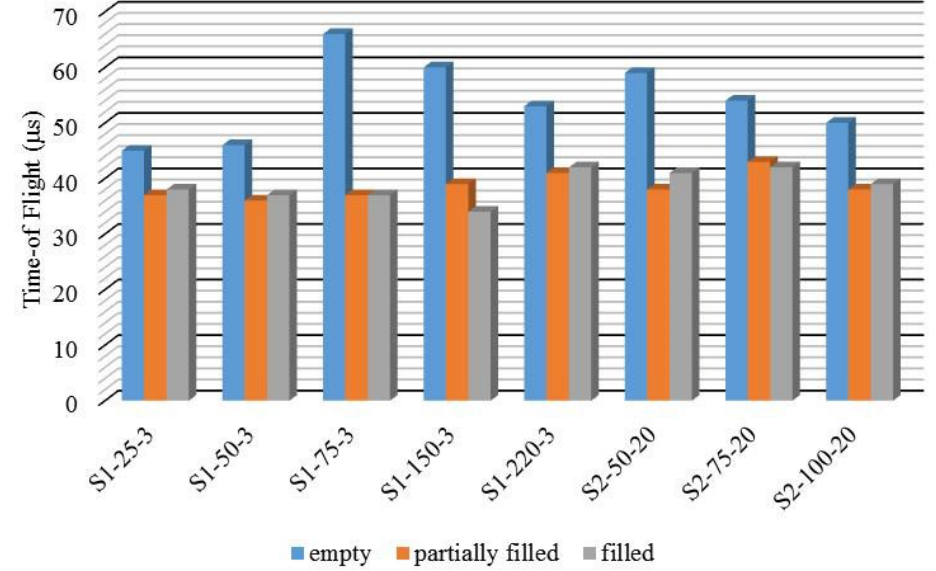
Figure 7. Time-of-flight between transducers 200 mm apart